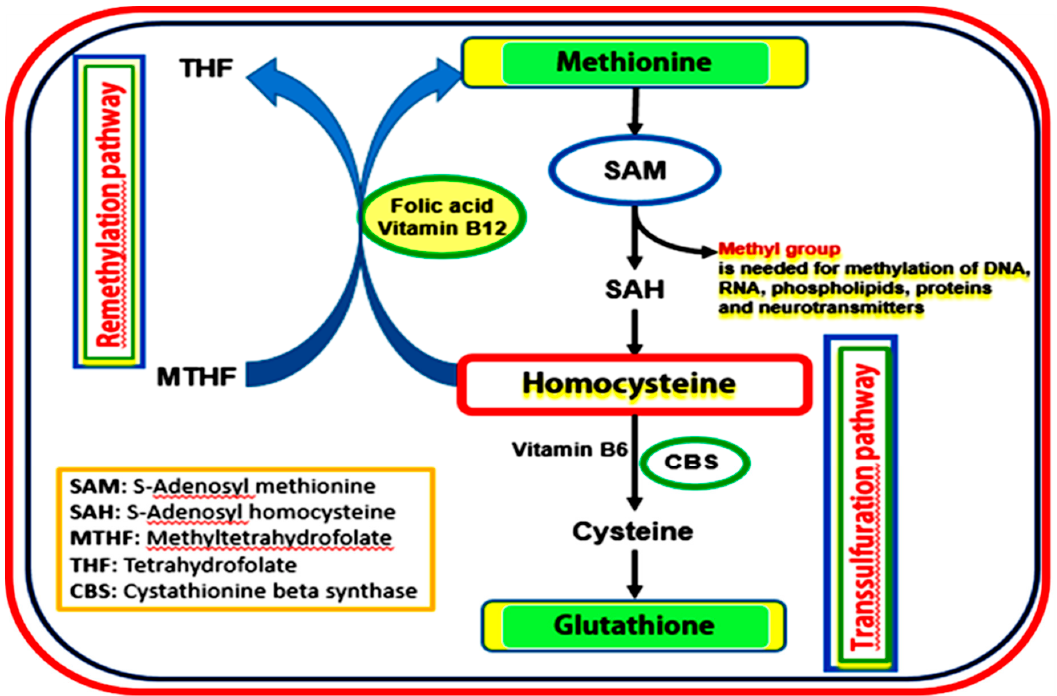
Figure 1. Pathways for homocysteine metabolism, showing the two main pathways for Hcy metabolism, the remethylation, and transsulfuration pathways.